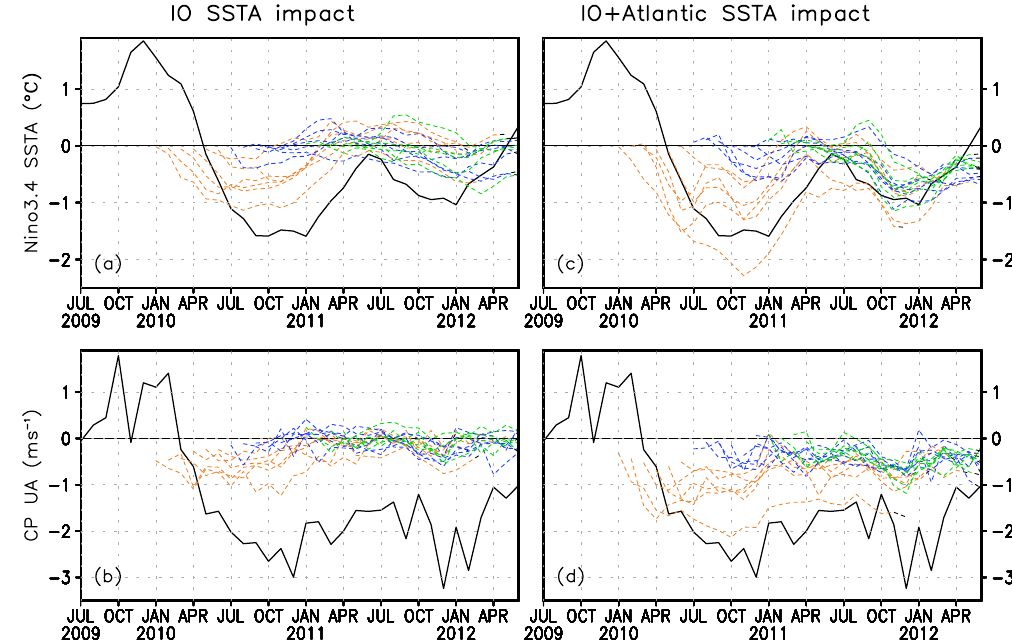
Figure 4. Impacts of the SST anomalies in the Indian Ocean and Atlantic Ocean on the predictability of the La Niña in 2010–12. ( a , b ) As in Fig. 2a and b, but for the differences in the first group of two sensitivity experiments in which observed climatological SST and observed monthly SST values are prescribed respectively in the Indian Ocean during the model’s two-year predictions (Methods). ( c,d ) As in ( a,b ), but for results based on the second group of two sensitivity experiments in which observed climatological SST and observed monthly SST values are prescribed respectively in both the Indian Ocean and the Atlantic during the model’s two-year predictions. Results are based on 9-member ensemble mean predictions. This figure is created using Grid Analysis and Display System (GrADS) Version 2.0.2